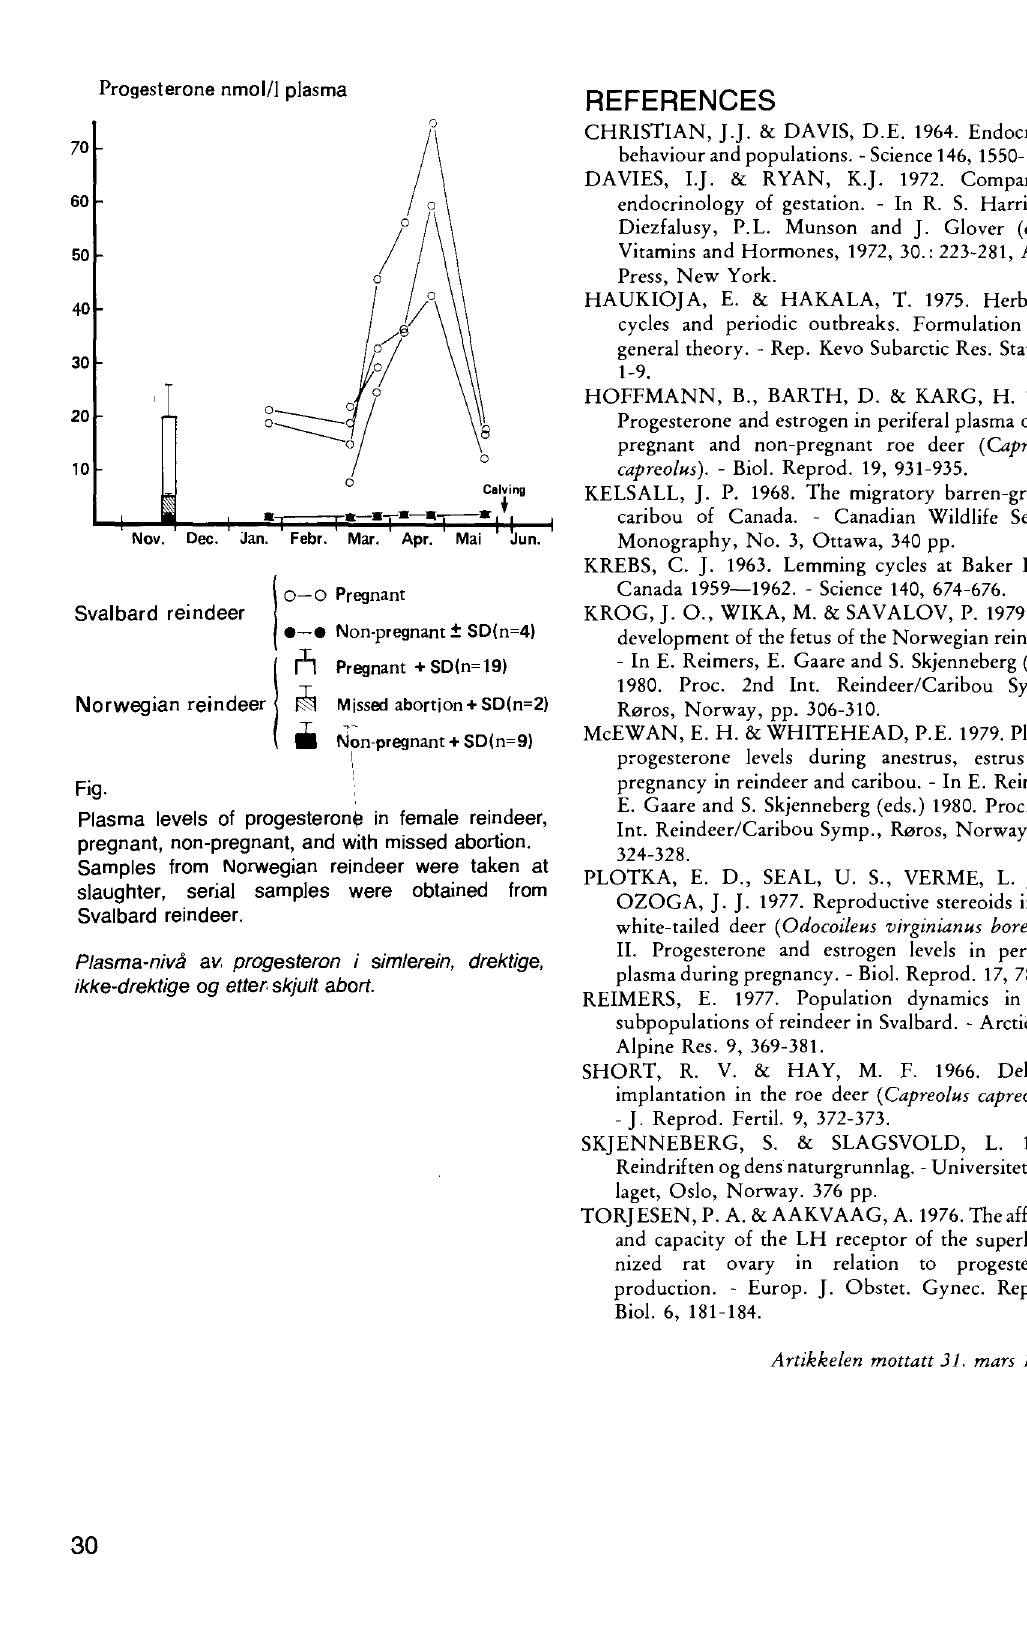
Fig. Plasma levels of progesteron^ in female reindeer, pregnant, non-pregnant, and with missed abortion. Samples from Norwegian reindeer were taken at slaughter, serial samples were obtained from Svalbard